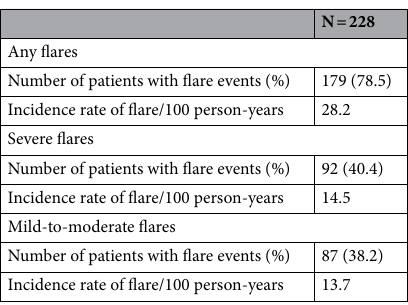
Table 2. Summary of flare